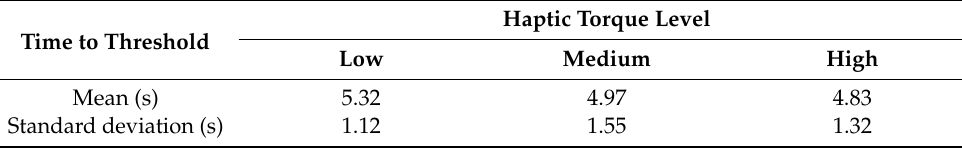
Table 4. Time to threshold for different haptic torque